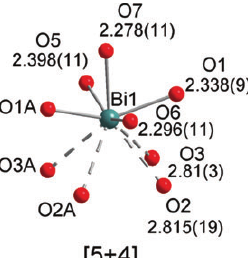
Figure 2 Oxygen coordination environment of the bismuth atom in the title compound. Symmetry transformations used: A = x, 0.5-y, z. Atomic positions of O2 and O3 are slightly disordered and have an occupation factor of 0.5 (Bi(1)–O(2 ′ ): 2.74(2) Å ; Bi1–O(3 ′ ): 2.88(2) Å ).